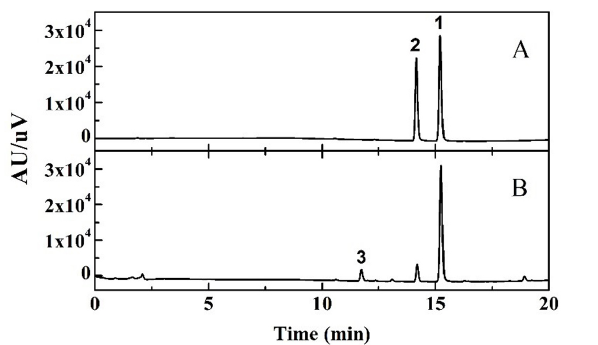
Fig. 3. HPLC chromatograms of extract of Gardenia fruit and reference solution. A: Extract of Gardenia fruit; B: